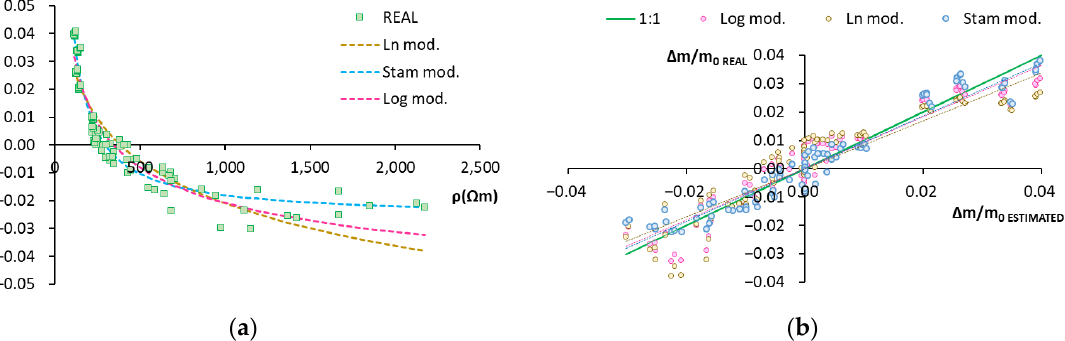
Figure 8. Model of humidity variation according to electric resistivity. ( a ) Graphical representation of the real data and those obtained with the models. Real data: green squares. Stam model: dashed blue line. Natural logarithm model: dashed yellow line. Decimal logarithm model: dashed pink line. ( b ) Graphical representation of the real data vs. the estimated ones. Stam model: blue dots. Natural logarithm model: yellow dots. Decimal logarithm model: pink dots. Table 5. Statistical parameters to evaluate the model’s goodness of fit of Δm/m 0 = f(ρ). Line Slope RMSE R 2 Real vs. Estimated Stam mod.